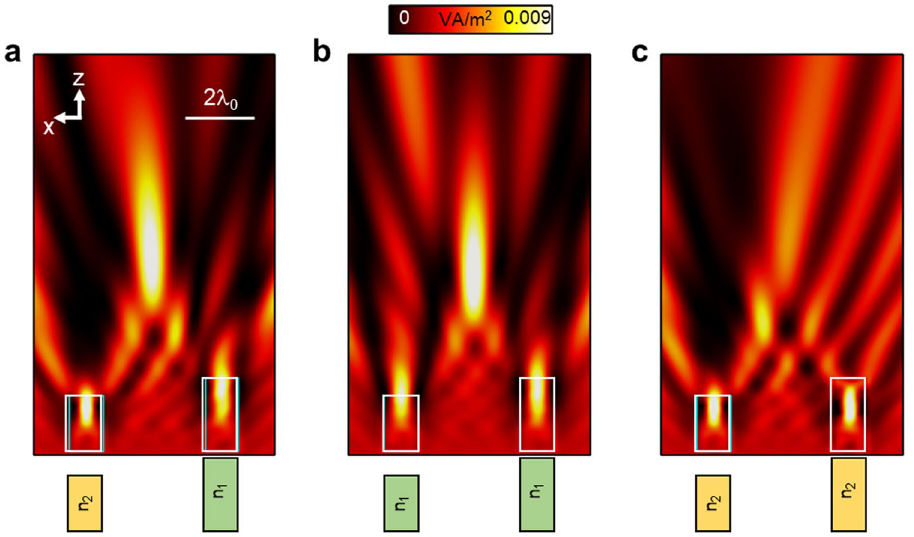
Figure 3. Numerical results of the power distribution on the xz plane for the dual-dielectric structure shown in Fig. 2a considering: ( a ) same results as those shown in the last panel of Fig. 2a with d = 3λ 0 where both dielectrics have a different refractive index, ( b ) when the dielectrics have a refractive index of n 1 = n 2 = 1.3 and when they are ( c ) n